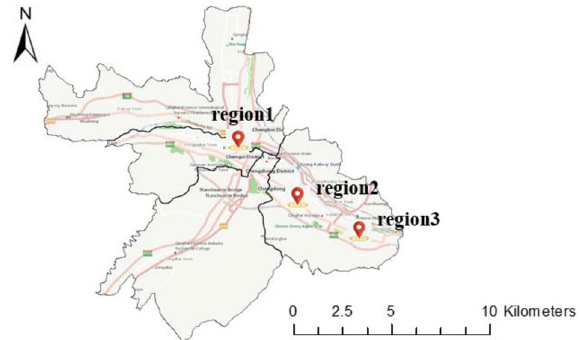
Figure 2. Three typical regions.